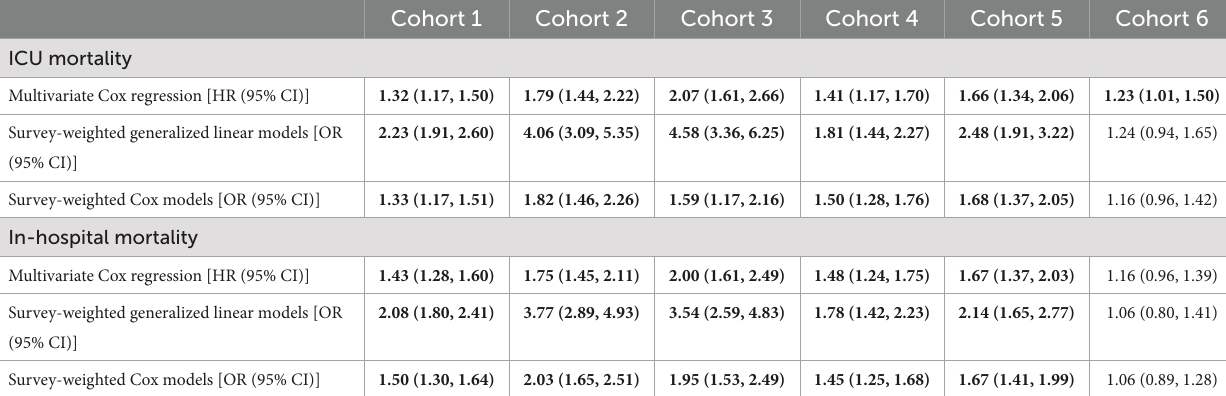
TABLE 2 Primary and secondary outcome analysis with three different models: (1) Multivariate Cox regression analysis model, (2) Survey-weighted generalized linear model of with all covariates using IPW; (3) Survey-weighted Cox model with all covariates using